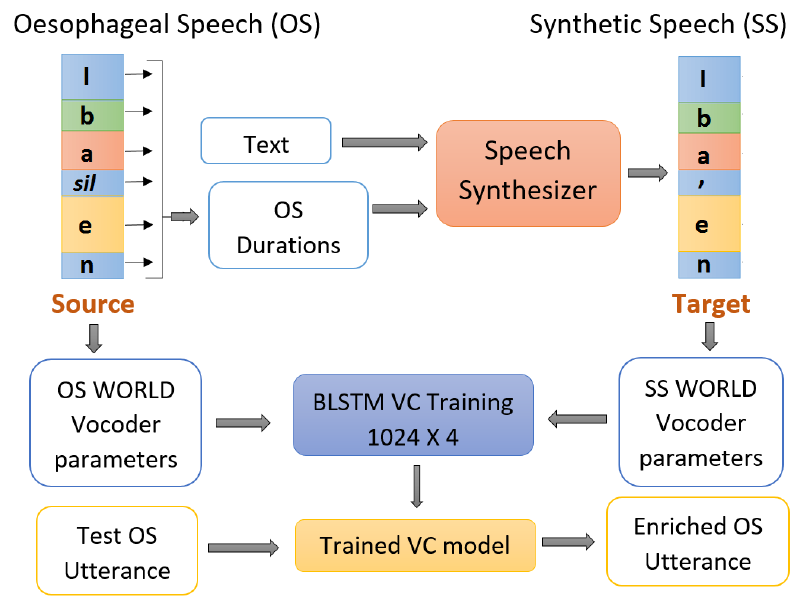
Figure 1. The proposed OS-HS VC system: